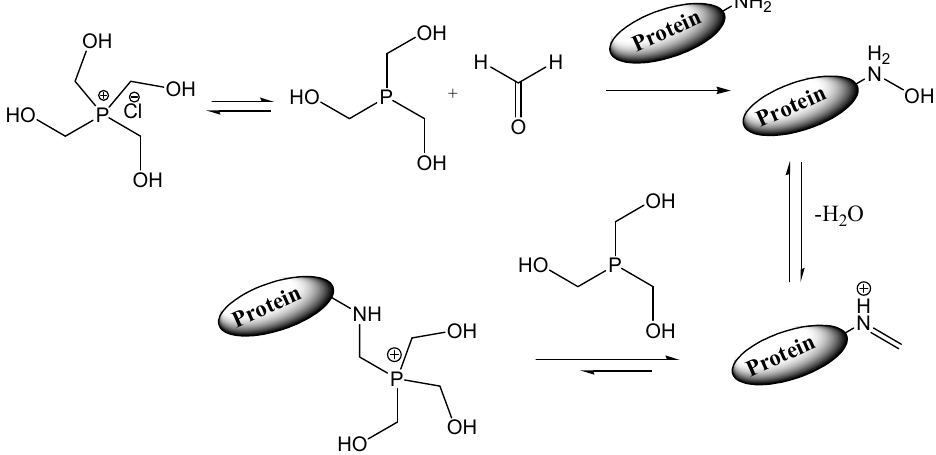
Figure 11. Mechanism of crosslinking proteins in the presence of tetrakis (hydroxymethyl) phosphonium chloride.